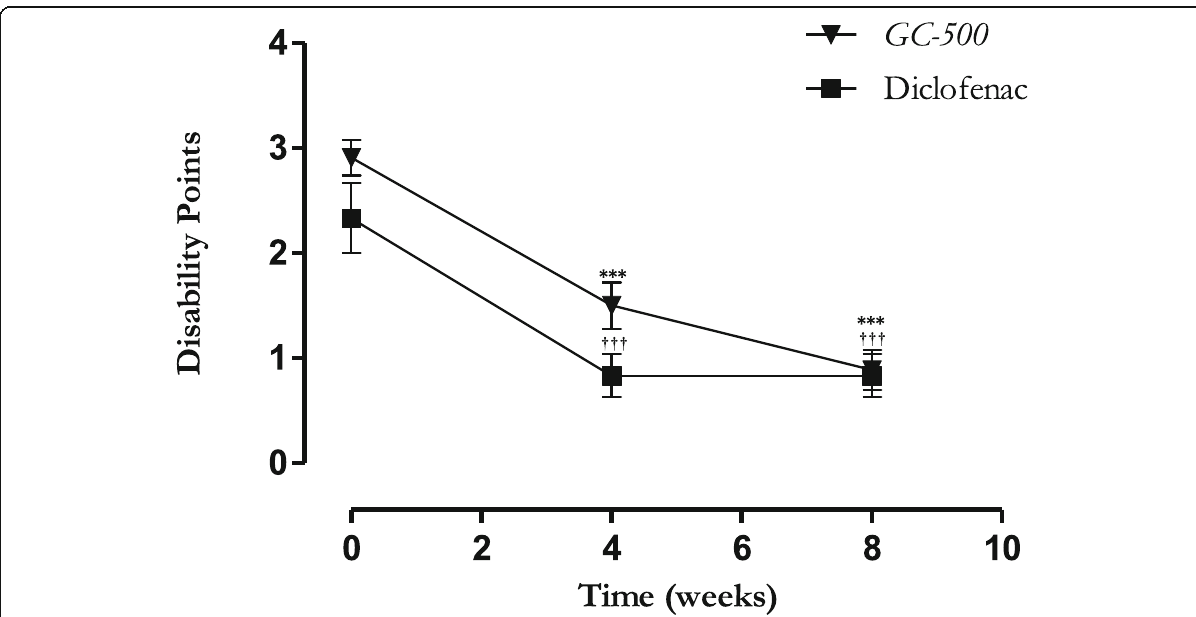
Fig. 5 Comparison of Disability Points for GC-500 and the Control over the Study Period. Data is expressed as Mean ± SD. A non-significant difference was observed between the groups p > 0.05 after ANOVA and Bonferroni post-hoc test . *** p < 0.001: GC-500 at week 4 & 8 compared to its baseline . ††† p < 0.001: Diclofenac at week 4 & 8 compared to its